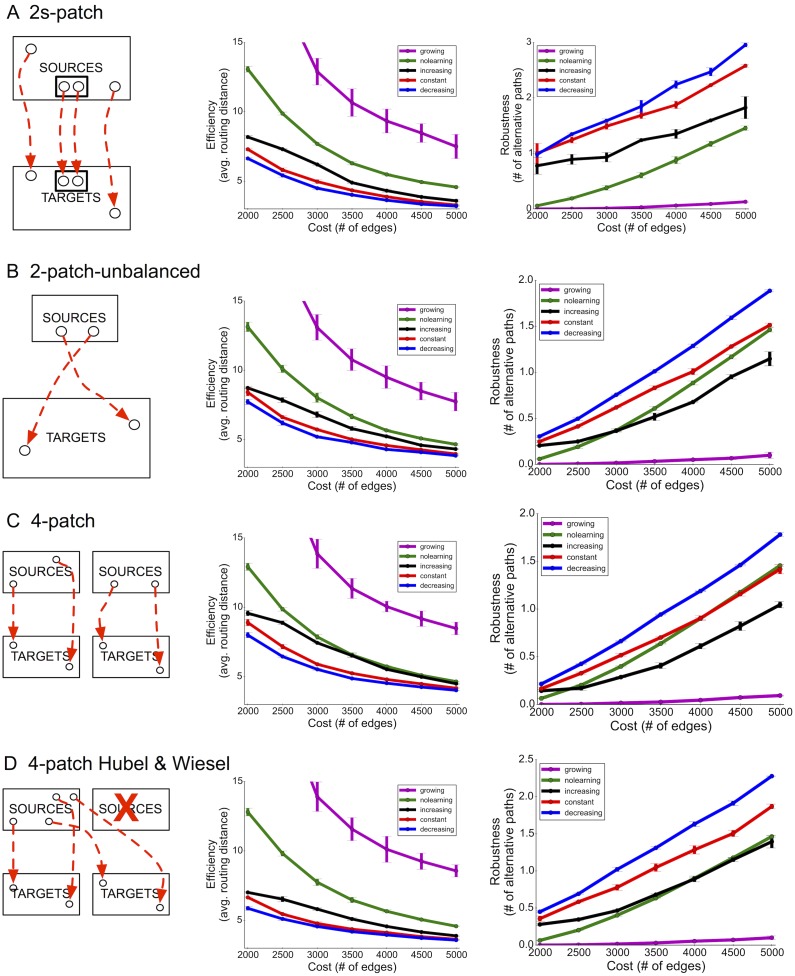
Additional source-target distributions.Decreasing rates are more efficient and robust than all other rates and algorithms for all four distributions: A) 2s-patch. B) 2-patch-unbalanced. C) 4-patch. D) 4-patch Hubel & Wiesel distribution, where during development one input source is lost entirely.